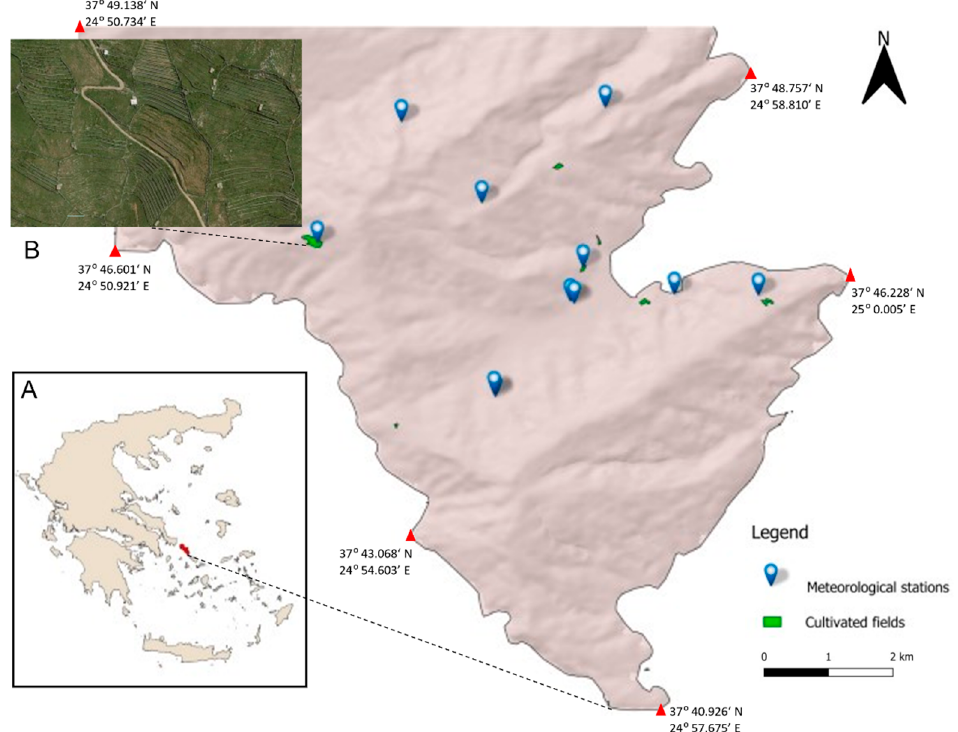
Figure 1. Map of the study area in Andros Island. The geographic location of Andros island is depicted (in red) on the map of Greece ( A ). The metereological stations and intervention sites are depicted by blue and green signs, respectively. A terraced site is also shown ( B ). The map was developed using the QGIS ver.3.10.6 open source GIS software and the 3D digital elevation model EUDEM ver.1.1 from the European Copernicus project. Coast line coordinates are indicated by red triangles. Map scale 1:1,000,000.